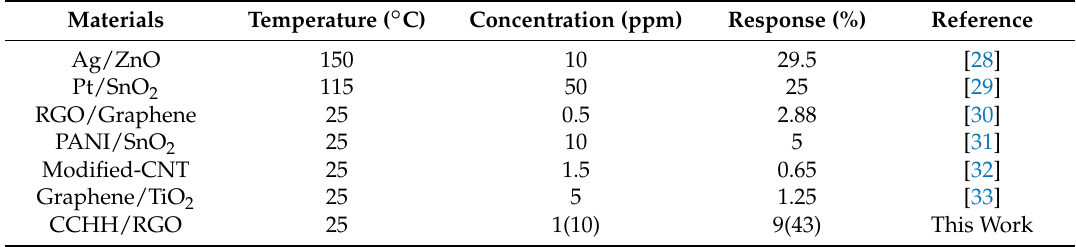
Table 2. Comparison of various indicators between different ammonia sensors.